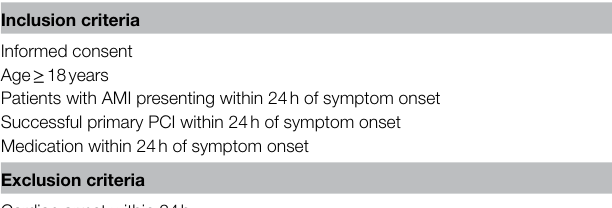
TABLE 1 | Key eligibility criteria for the ASV-acute myocardial infarction (AMI) study. Inclusion